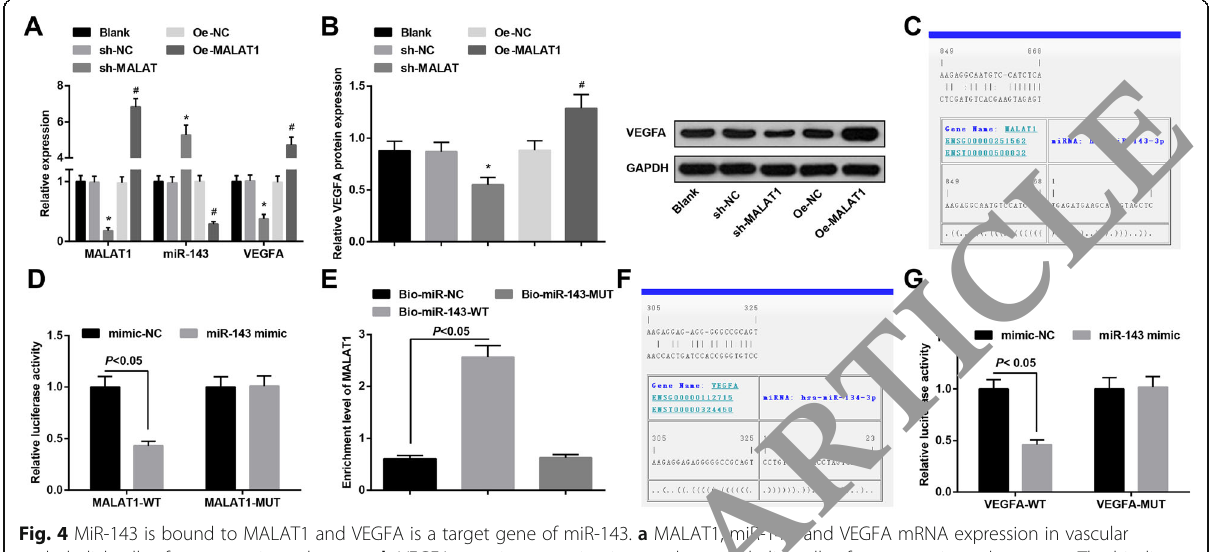
Fig. 4 MiR-143 is bound to MALAT1 and VEGFA is a target gene of miR-143. a MALAT1, miR-143, and VEGFA mRNA expression in vascular endothelial cells of aneurysm in each group. b VEGFA protein expression in vascular endothelial cells of aneurysm in each group. c The binding sites of MALAT1 and miR-143 predicted by the bioinformatics website. d The regulatory relation of MALLA1 and miR-143 validated by dual luciferase reporter gene assay. e The binding relationship between MALAT1 and miR-143 verified by RNA-pull down assay. f The binding sites of miR-143 and VEGFA predicted by the bioinformatics website. g The regulatory relation of miR-143 and VEGFA validated by dual luciferase reporter gene assay. * P < 0.05 vs. the sh-NC group, # P < 0.05 vs. the Oe-NC group. Measurement data were depicted as mean ± standard deviation, comparisons between two groups were assessed by independent sample t test, and comparisons among multiple groups were assessed by one-way analysis of variance followed with Tukey ’ s multiple comparisons